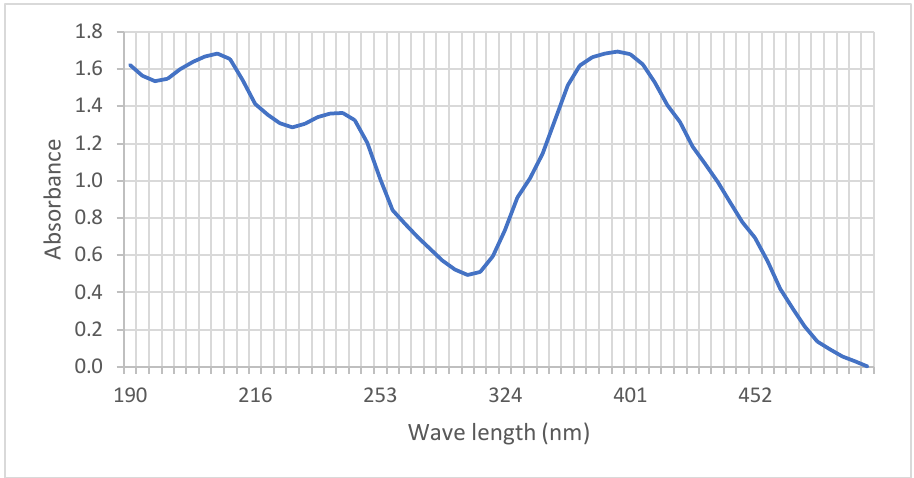
Figure 3. Absorbance vs. wavelength for Direct Yellow RL; the maximum absorbance is 396 nm.